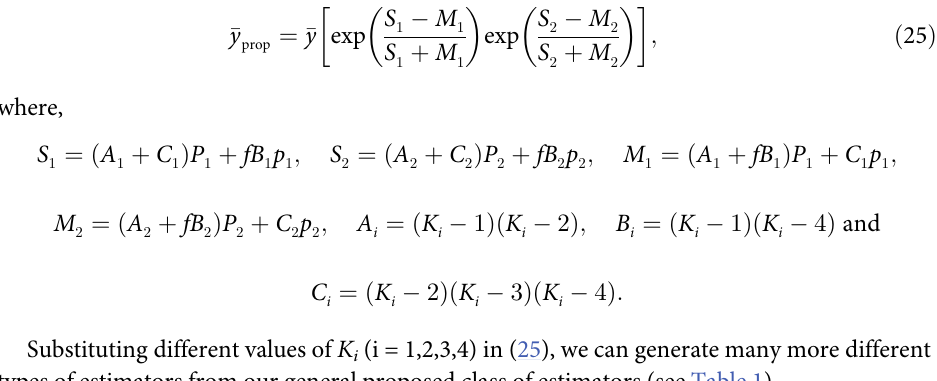
In the lines of Shukla et al. [12], we proposed a generalized class of factor type estimators for mean estimator. The proposed estimator, is given by: